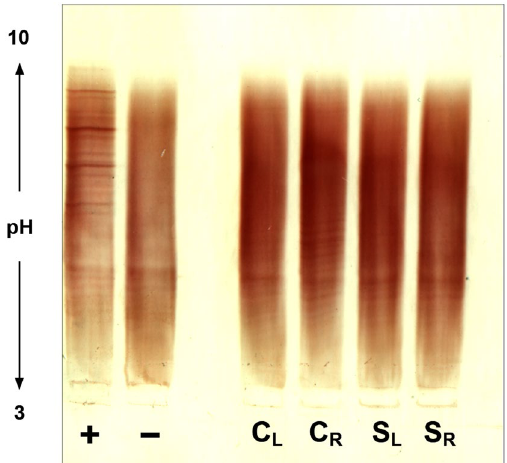
Figure 4. Analysis of tear fluid by isoelectric focusing for the detection of oligoclonal IgG bands. Tear fluid collected with capillary tubes ( C ) and Schirmer strips ( S ) from the left ( L ) and right ( R ) eye of a healthy subject was analyzed by isoelectric focusing and IgG was visualized in an immunoblot. Samples as well as CSF positive ( + ) and negative (−) controls were analyzed at an IgG concentration of 4 µg/ml. Distinct oligoclonal IgG bands can be found in the positive control ( + ). A clear polyclonal IgG signal was obtained in all tear fluid samples, which were negative for oligoclonal IgG bands. The section displayed was vertically cropped from both sides. The full-length blot is presented in Supplementary Figure